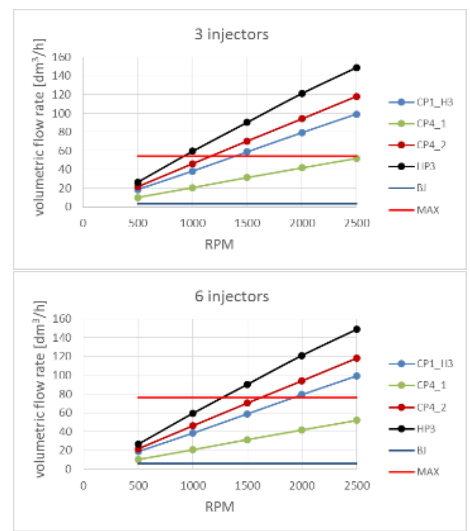
Fig. 5. Comparison of pump volumetric flow rates with the required pump volumetric flow rate – with three and six injectors